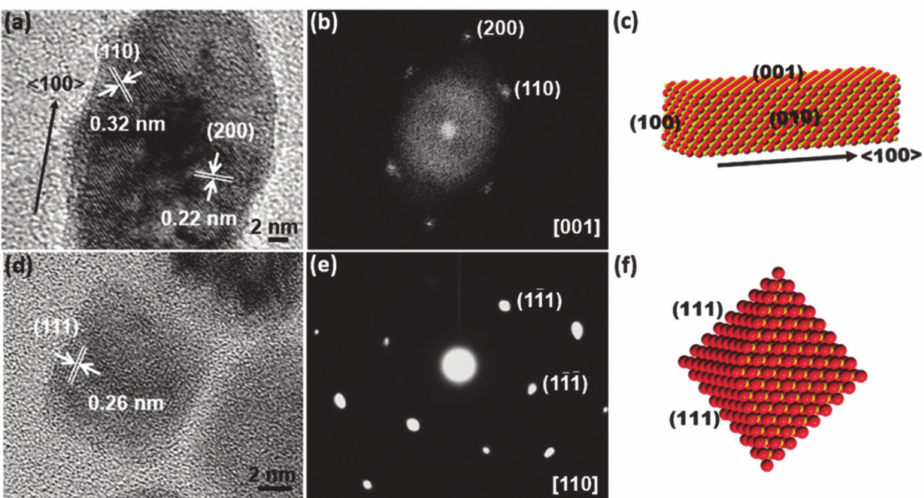
Figure 5. ( a,b ) The high-resolution transmission electron microscope (TEM) image of a single rod of MnO polypods ( a ) and the corresponding selected area electron di ff raction (SAED) pattern ( b ). ( c ) Schematic illustration indicating the growth direction and exposed planes of MnO nanorods on MnO polypods. ( d,e ) The high-resolution TEM image of a single MnO octahedral nanoparticle (NP) (d) and the corresponding SAED pattern ( e ). ( f ) Schematic illustration indicating the growth direction of MnO octahedral NPs. O is red and Mn is yellow. Reproduced with permission [125]. Copyright 2015, Royal Society of